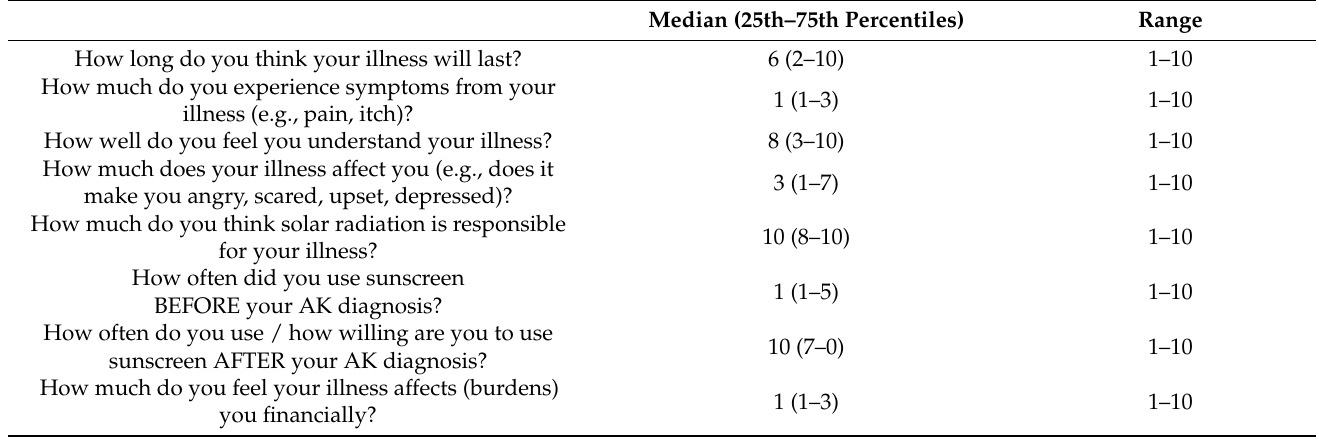
Table 3. Illness perception questions based on Brief IPQ model, Questionnaire Part